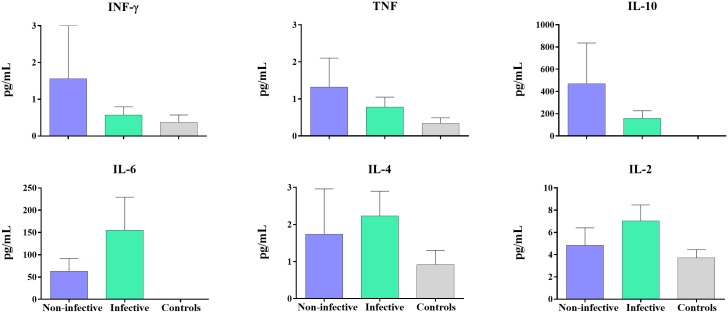
Cytokines levels (pg/mL) of 24 P. vivax volunteers.Levels of cytokines measured in P. vivax-infected volunteers bitten by 30 uninfected An. albimanus mosquitoes during DFA are shown divided in two categories: non-infective and infective to mosquitoes (median + interquartile range).